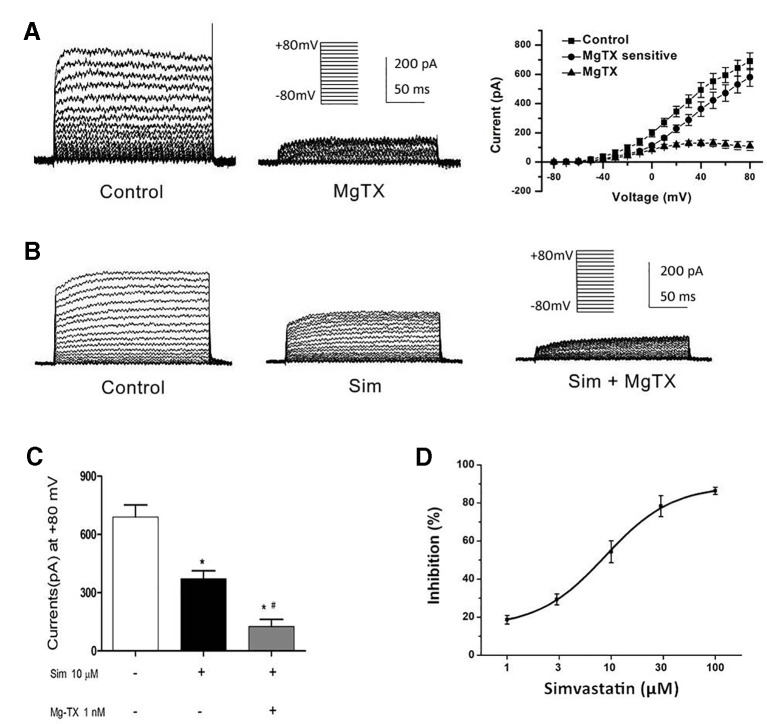
Effects of simvastatin on Kv1.3 current intensity change in THP-1 cells measured by whole-cell clamp patch. (A) Kv1.3 current was detected with a series of test potentials of 300 ms duration from −80mV to +80mV in 10 mV increments from a holding potential of −70mV. The currents were blocked by 1 μM MgTX. (B) Simvastatin treatment significantly inhibited the current intensity of Kv1.3. (C) The 10 μM simvastatin treatment remarkably inhibited the current intensity of Kv1.3 vs. control, *P < 0.05 vs. controls, and the addition of 1 nM MgTX further inhibited the current intensity compared with the simvastatin treatment alone, #
P < 0.05 vs. inhibitor treatment, when the voltage was set at +80 mV, n = 4 for each group. (D) The does-response data of the Kv1.3 current at +40 mV was summarized (n = 4 for each concentration) and fitted with Boltzmann equation. The IC50 was calculated to be 8.75 ± 1.25 μM.